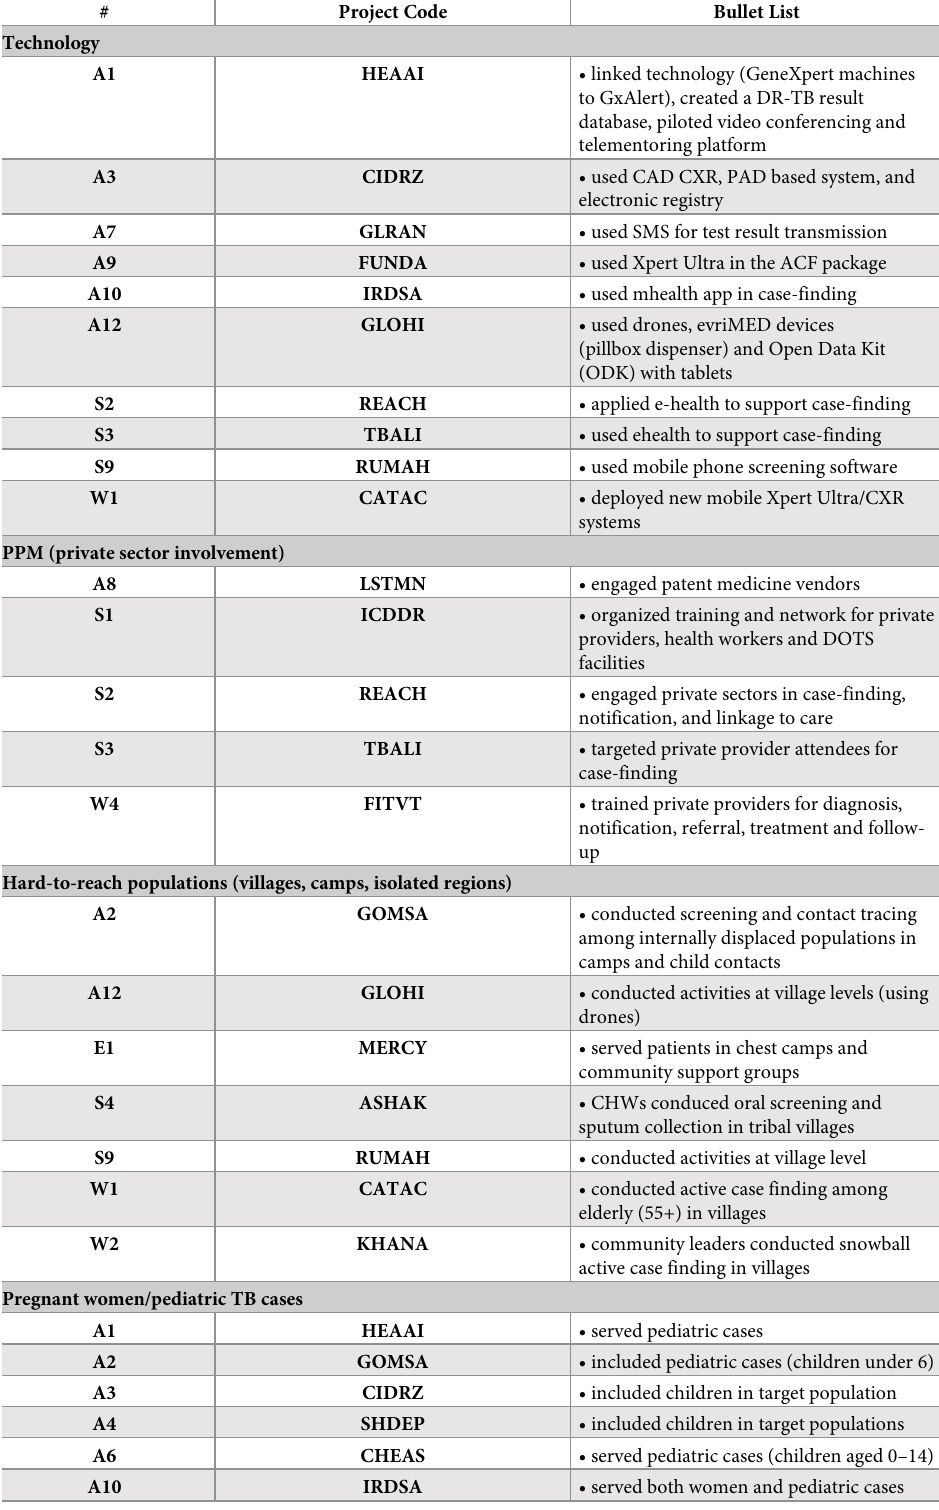
Table 2. Projects organized by